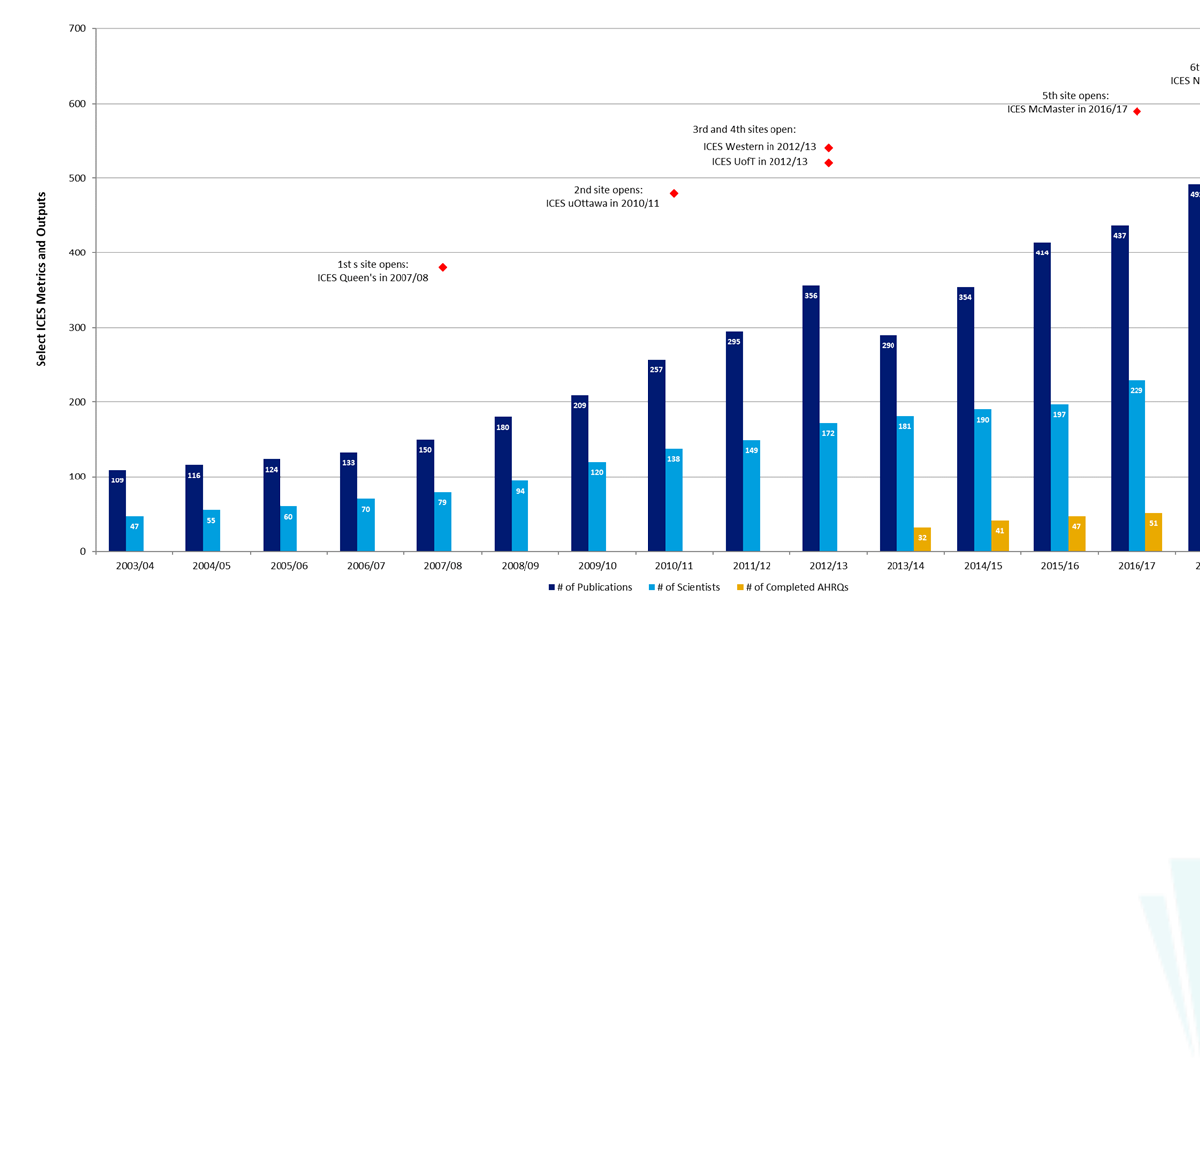
Figure 1: ICES Productivity 2003/04 to